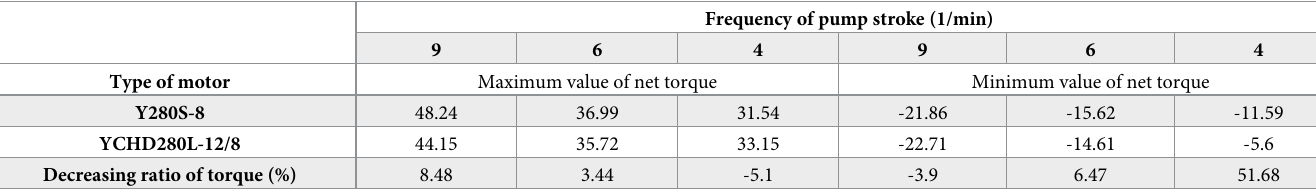
Table 5. Comparison of the output torque of the